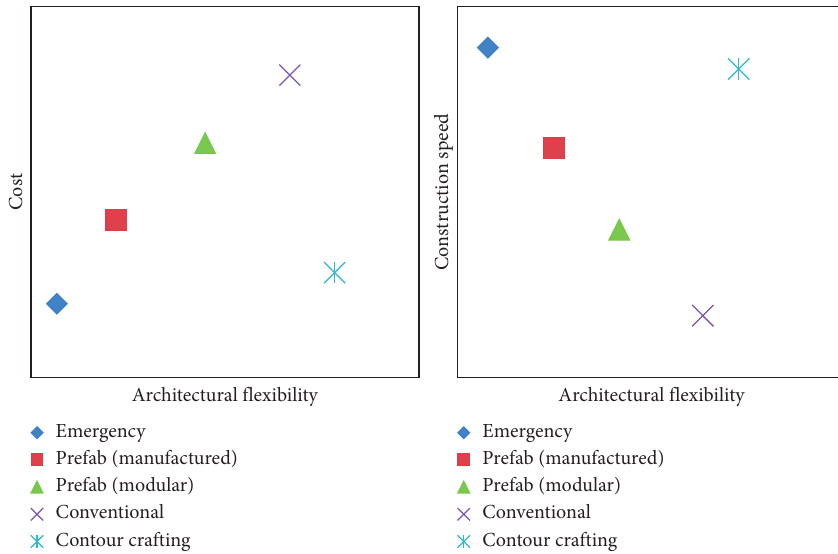
Figure 5: CC architectural flexibility in relation to its cost and construction speed [15].